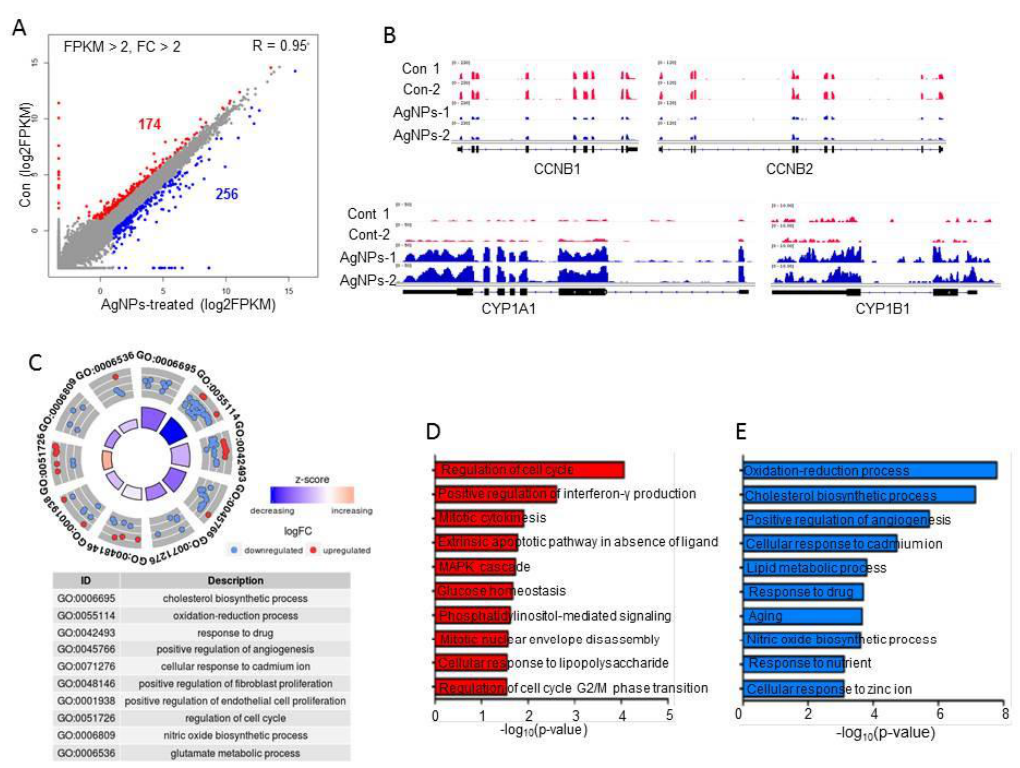
Figure 7. Impact of AgNPs on gene expression. ( A ) Scatter plot showing up- and downregulated genes in AgNP-treated HCT116 cells. The log 2 fragments per kilobase of transcript per million mapped reads (FPKM) values were used for plotting. Red and blue dots indicate downregulated and upregulated genes in AgNP-treated HCT116 cells, respectively. Cut-off: FPKM >2 and fold change >2. ( B ) Representative IGV images of down- ( CCNB1 and CCNB2 ) and upregulated ( CYP1A1 and CYP1B1 ) genes. ( C ) Gene Ontology (GO) term analysis using both up- and downregulated genes. Each red (downregulated) or blue (upregulated) dot represents one gene belonging to each term. ( D , E ) bar graphs showing GO terms of individual up- and downregulated genes.